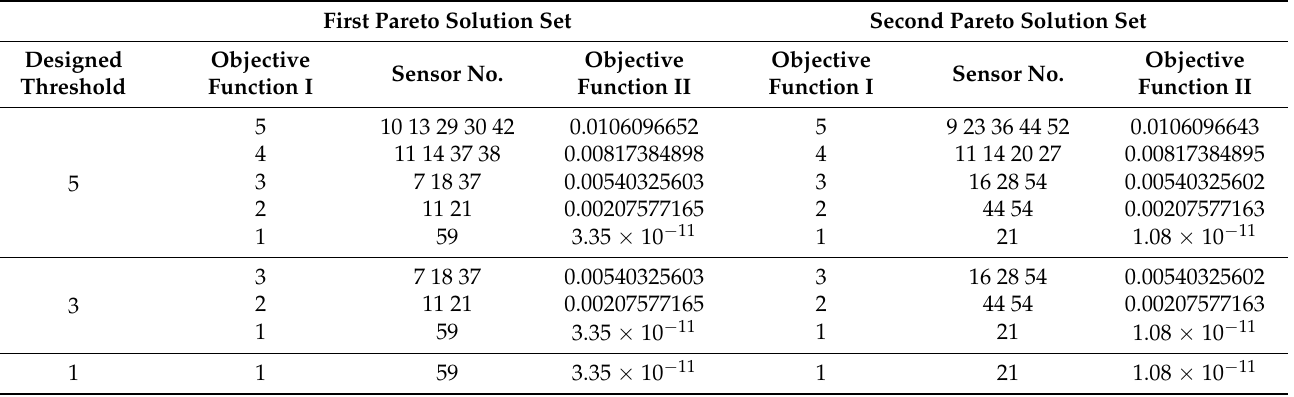
Table 3. The optimization results of the 9 × 9 grid.